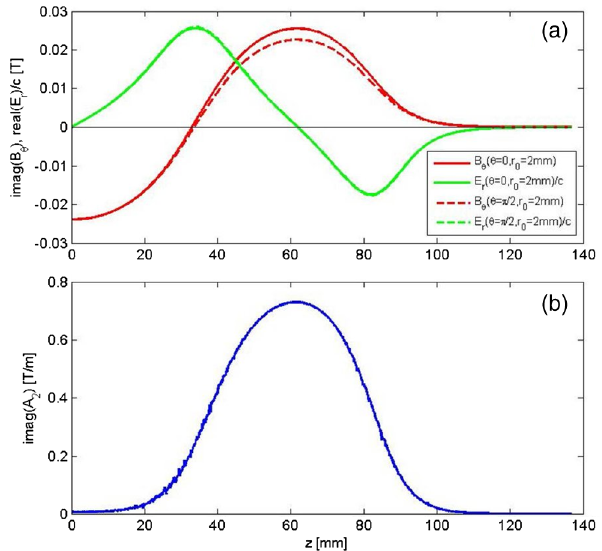
FIG. 34. (a) Phasors of the azimuthal magnetic and electric fields for θ ¼ 0 and π = 2 as a function of z for r 0 ¼ 2 mm.